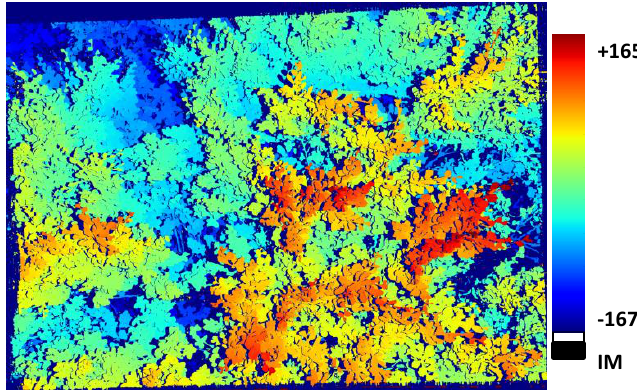
Figure 4. Disparity map generated from stereo matching.